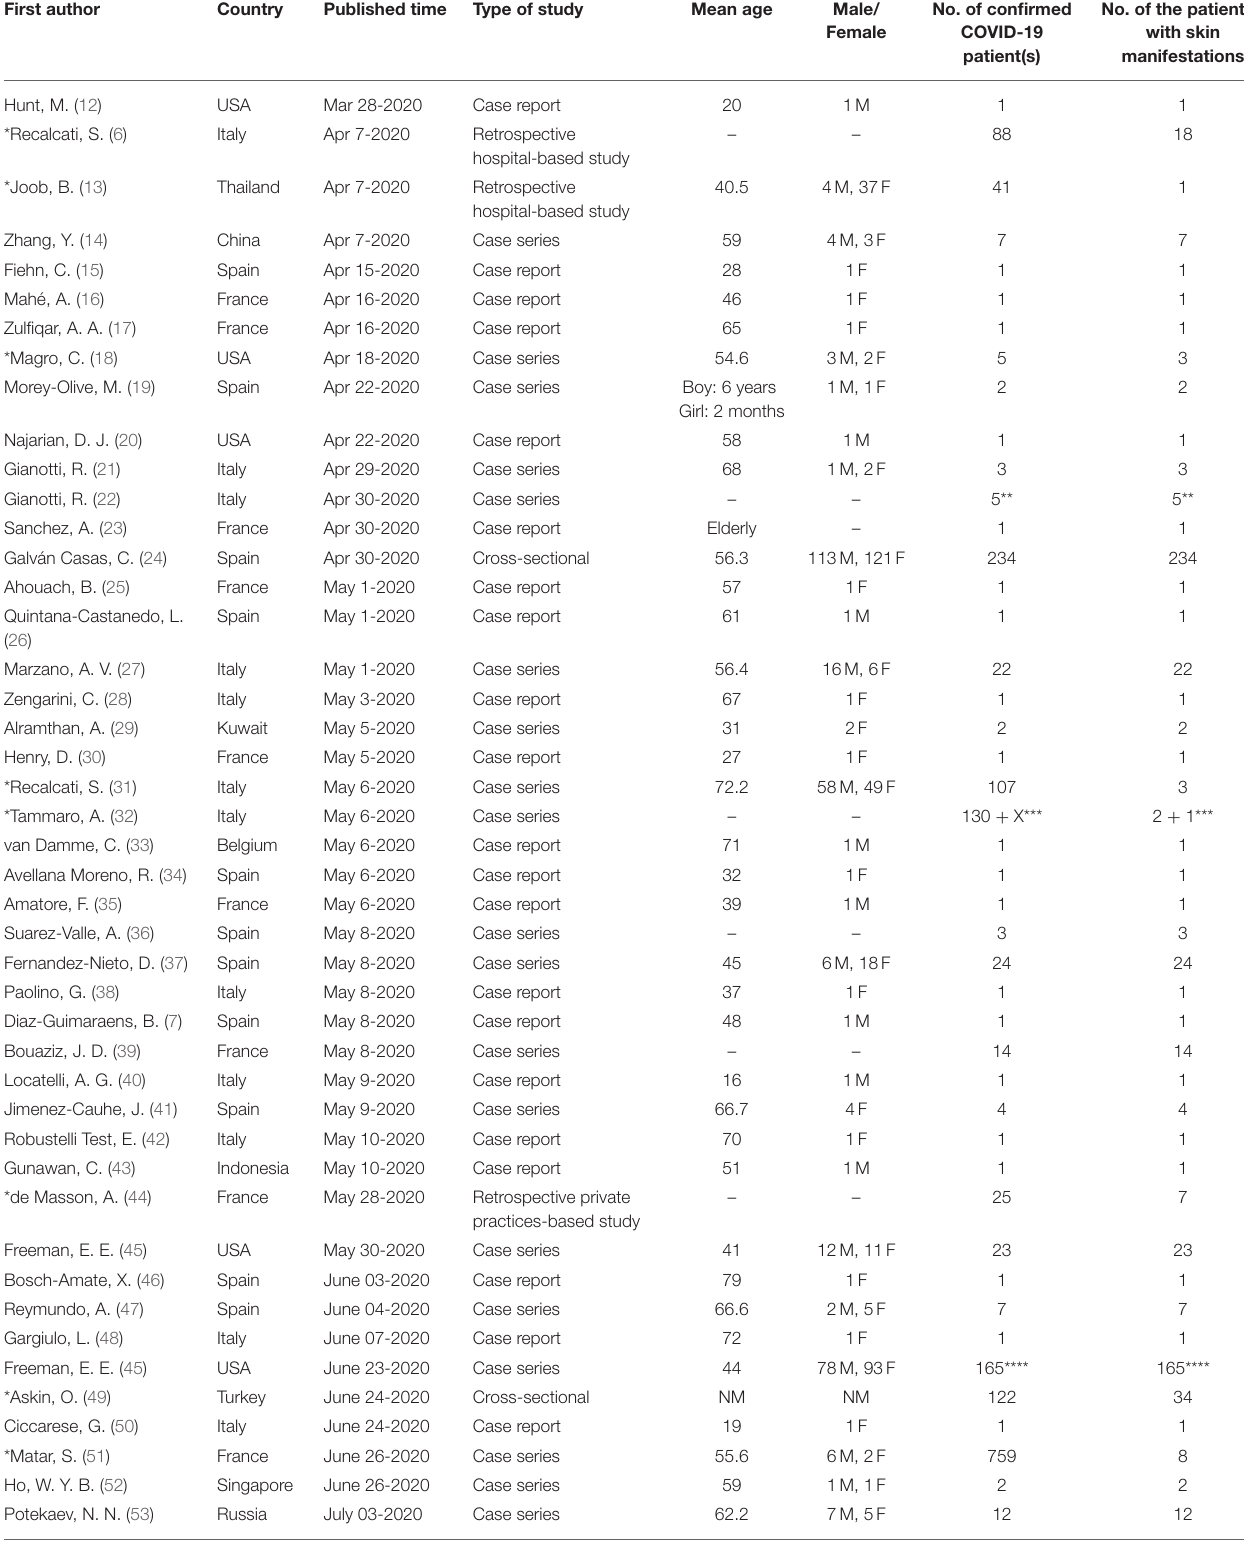
TABLE 1 | Characteristics of the included